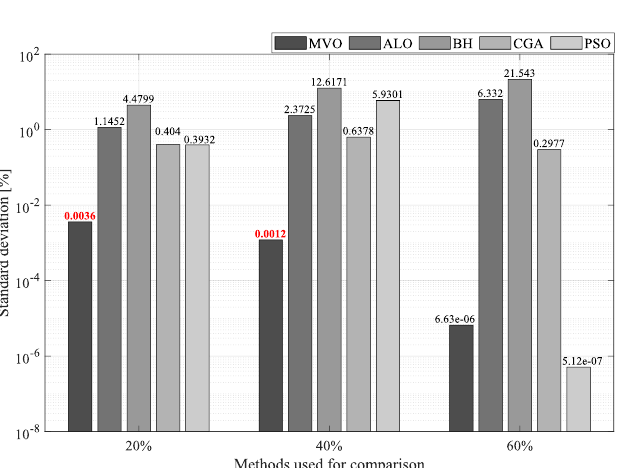
Figure 9. Standard deviation obtained by the SSA in the 69-node system compared to that of the other